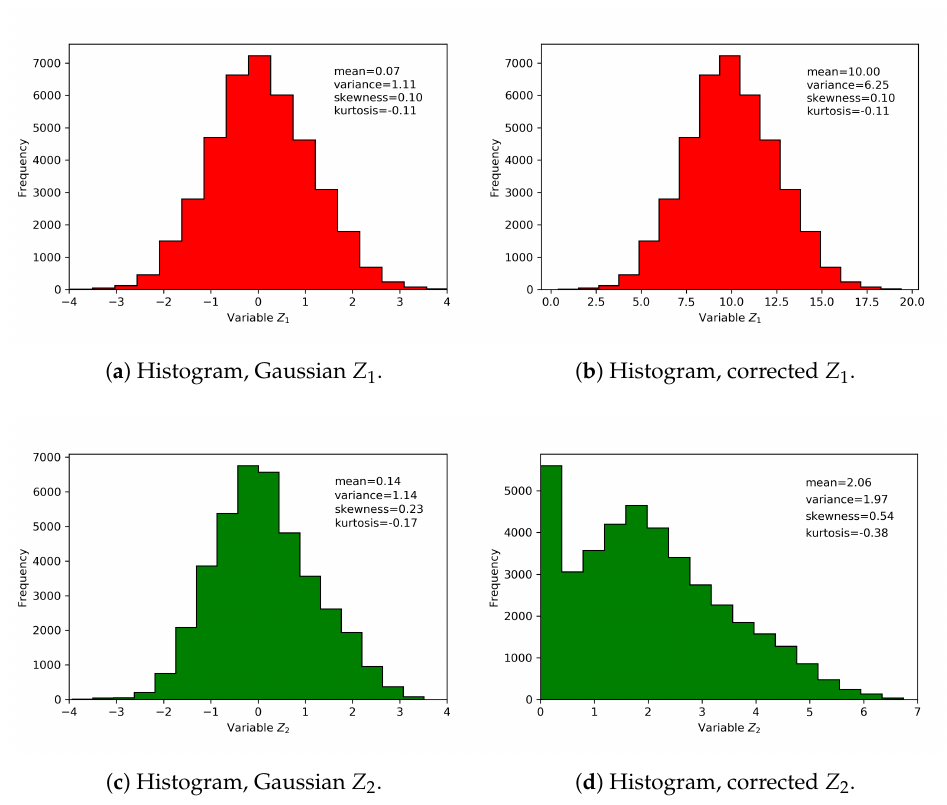
Figure 2. Histograms, Gaussian variables and transformed variables.